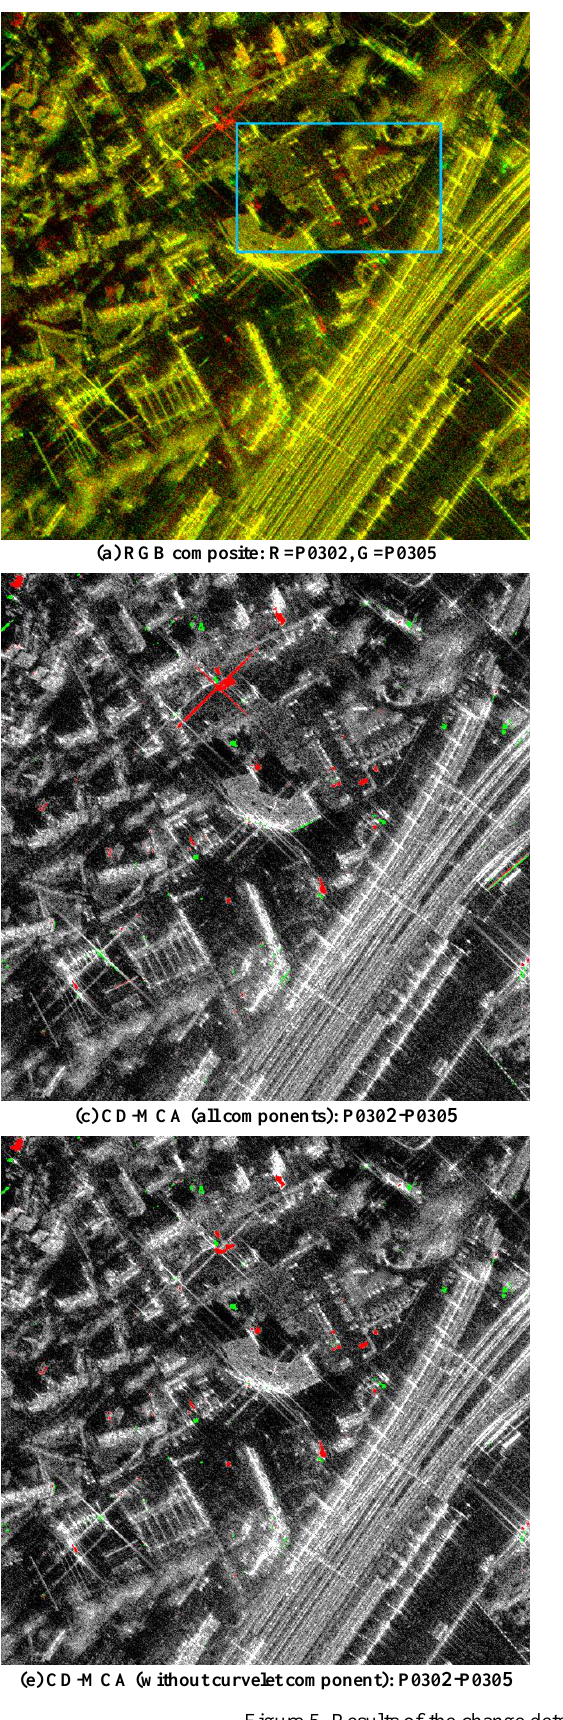
Figure 5. Results of the change detector in the residential